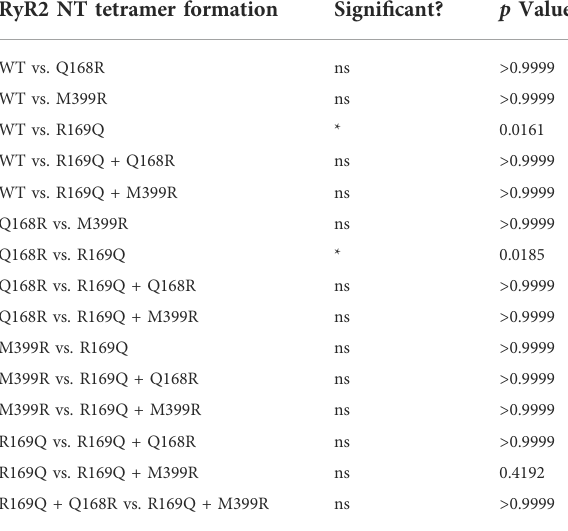
TABLE 2 Chemical cross-linking assays (n ≥ 7) of RyR2 NT WT , NT Q168R , NT M399R , NT R169Q , NT R169Q+Q168R and NT R169Q+M399R as described in the legend toFigure2.Statisticalanalysis wascarriedout for tetramer formation at 60 min of cross-linking using Kruskal – Wallis test with Dunn ’ s multiple comparison